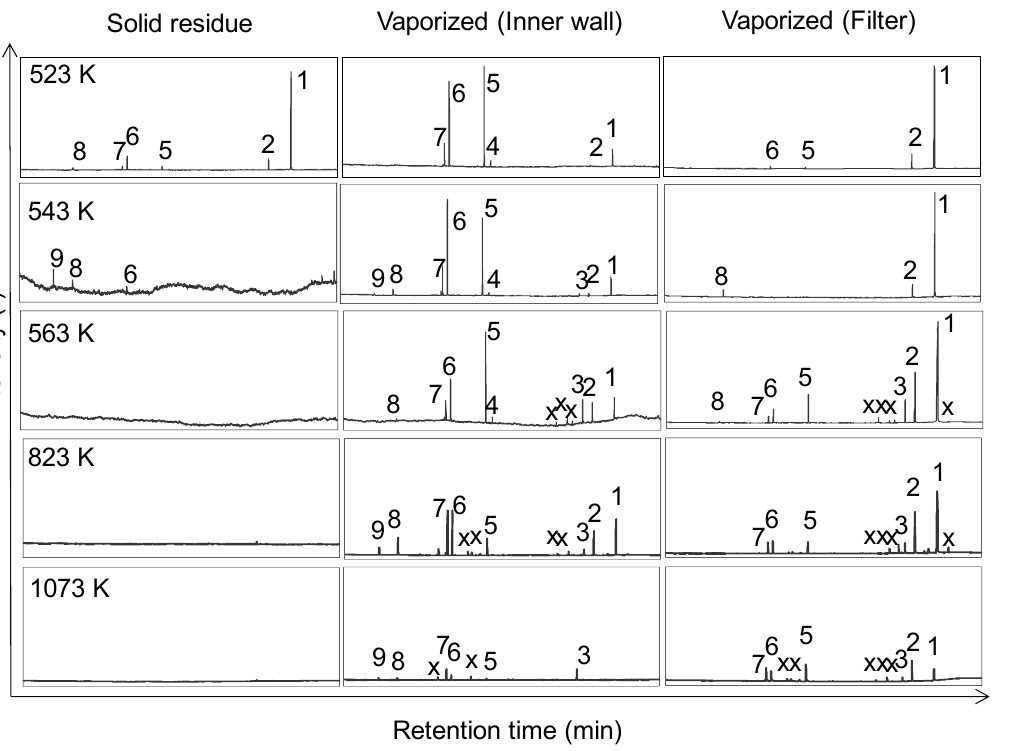
Figure 2. Total ion chromatograms of organic products from the thermal treatment of TBBPA:ZnO (3.34:1) at Argon atmosphere for 40 min at selected